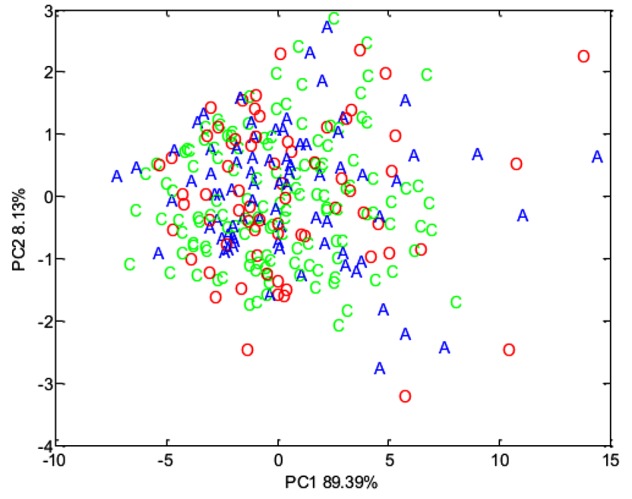
Principal component analysis (PCA) plot summarizing fecal metabolome data derived from the host phenotypic groups: Aged (A) (n = 11), Control (C) (n = 12), and Obese (O) (n = 12).